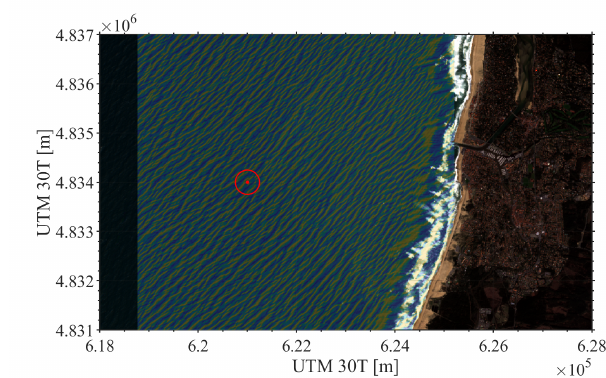
Figure 6. Radon-filtered wave pattern (normalized) from Sentinel-2 imagery collected on 30 March 2018. The red circle indicates the position related to the Radon-derived wave spectrum.